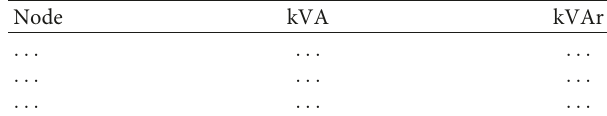
Table 1: Load data table.